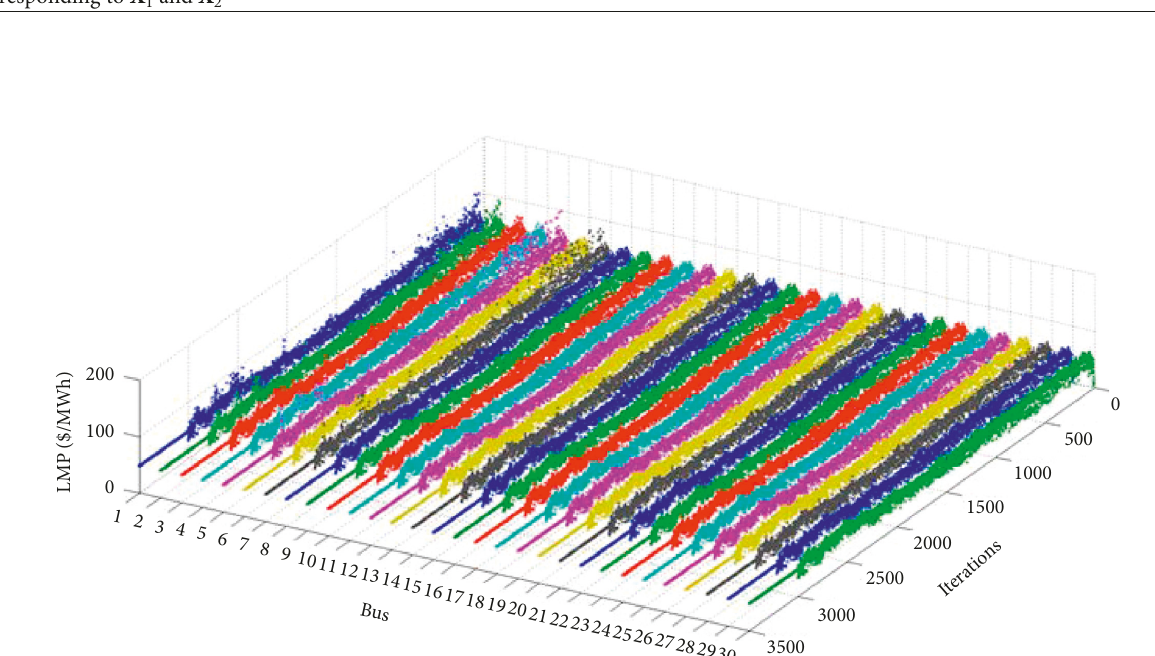
Figure 2: Dynamic adjusting process of hour-ahead LMPs in the GDCAC-based approach.